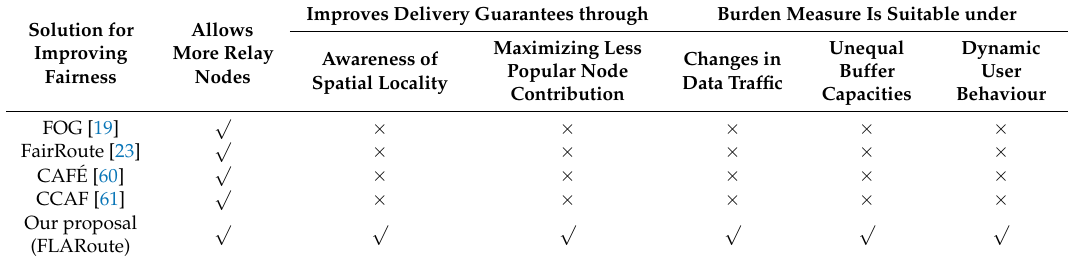
Table 2. Solutions for improving OppNet routing fairness, their main features and the novelty of